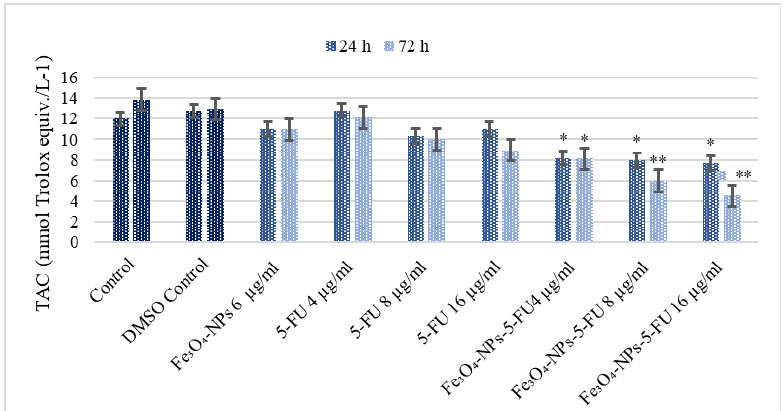
Figure 5. The effect of Fe 3 O 4 0-NPs, 5-FU, and Fe 3 O 4 -NPs + 5-FU on Caco-2 cells’ TAC (n = 6). Cells were cultured in 96-well plates and treated with Fe 3 O 4 NPs 6 μg/mL, 5 - FU (4, 8, and 16 μg/mL), and Fe 3 O 4 + 5-FU NPs combinations for 24 h and 72 h, and TAC determined. The results represent the average of three separate experiments. Statistical significance: * p < 0.05; ** p < 0.01. In correlation with the TAC results, the combined Fe 3 O 4 -NPs + 5-FU treatments (Figure 6) was found to increase Caco-2 cell TOS levels, dependent on time and concentration. The most pronounced effects were obtained after 72 h of treatment with Fe 3 O 4 -NPs + 5U 8 µg/mL/5-FU 16 µg/mL ( p < 0.01).